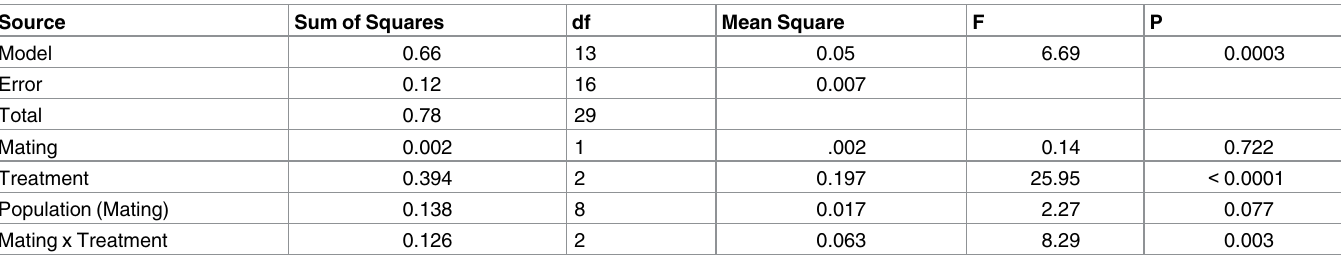
Table 1. ANOVA table for competitive fitness.